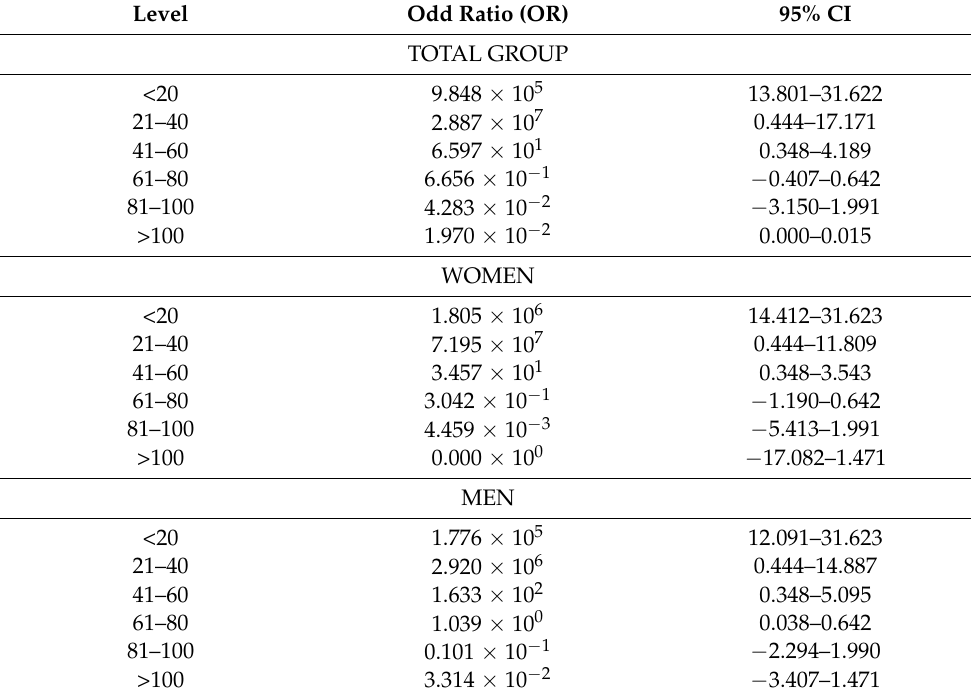
Figure 2. Contribution percentage of the coverage of total RDA for iodine according to ranges (above 100% RDA; 81–100% RDA; 60–80% RDA; 41–60% RDA; 21–40% RDA; below 20% RDA) among women and men in different diet groups (vegan, omnivore) aged 18–80 from Poland; different letters (a–d) denote a significant difference at p < 0.05 (one-way ANOVA, and post hoc Tukey test) between men and women in different diet groups (vegan, omnivore) within a given RDA ranges. Table 4. Results of logistic regression analysis to the covering the Recommended Dietary Allowance of iodine among people with vegan Diet.